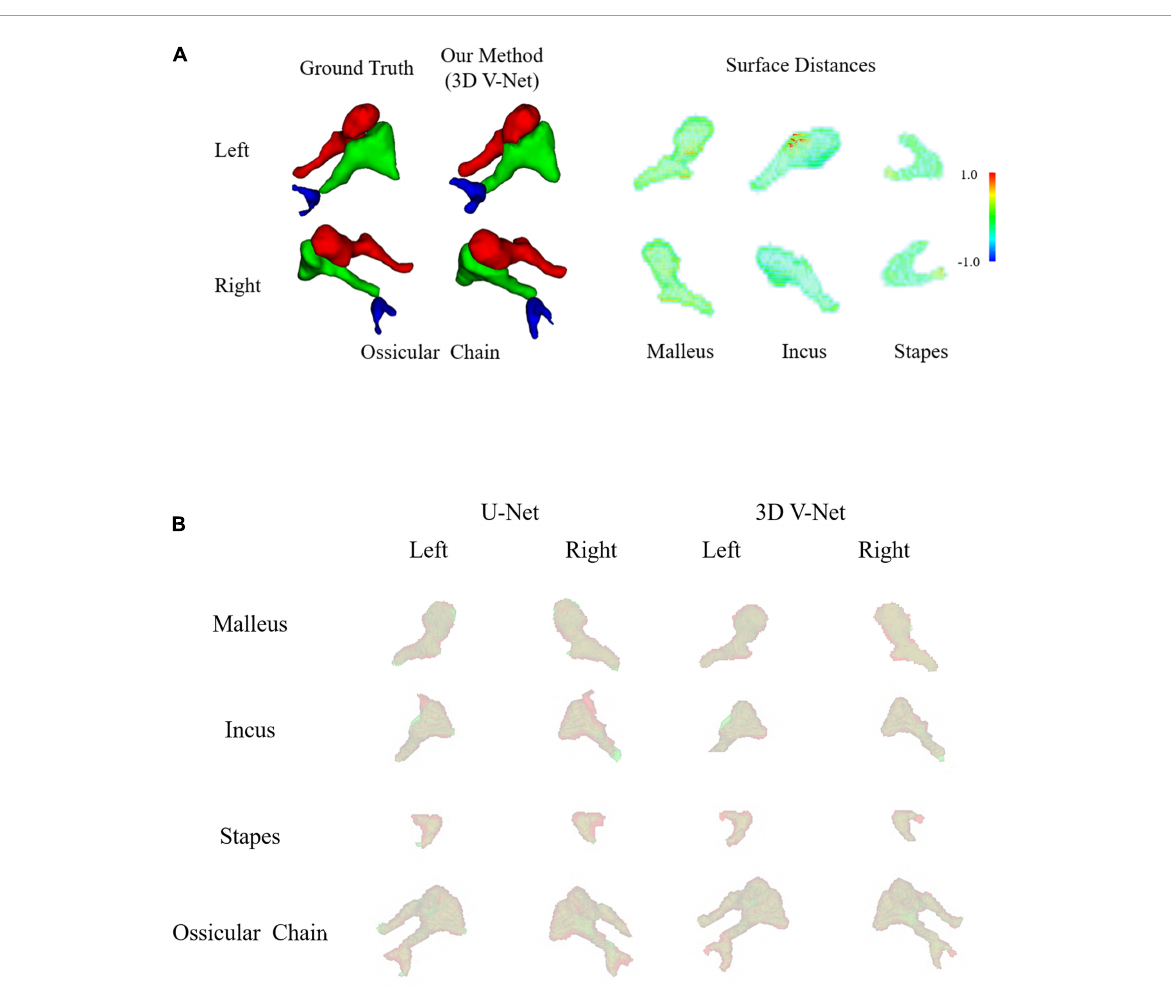
FIGURE5 (A) A three-dimensional display of the segmentation results. On the left side is the segmentation result of the ground truth and the 3D V-Net method. The right side shows the difference in the surface distance between the two results. The auditory ossicles comprise the malleus, incus, and stapes. In this paper, positive values represent over-segmentation, and negative values represent under-segmentation. The left side of the figure corresponds to the left auditory ossicles, and the right corresponds to the right auditory ossicles. (B) Comparison of the segmentation results. The segmentation results of the two methods are compared with the surface coincidence degree of the ground truth. Green is the ground truth reconstruction, and red is the segmentation result